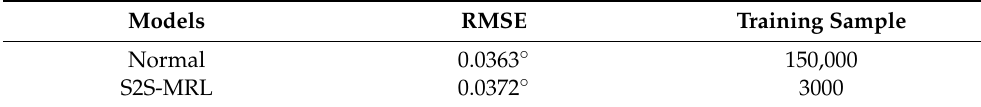
Table 4. Comparison table of training sample size of two methods in approximate RMSE based on the new environment.